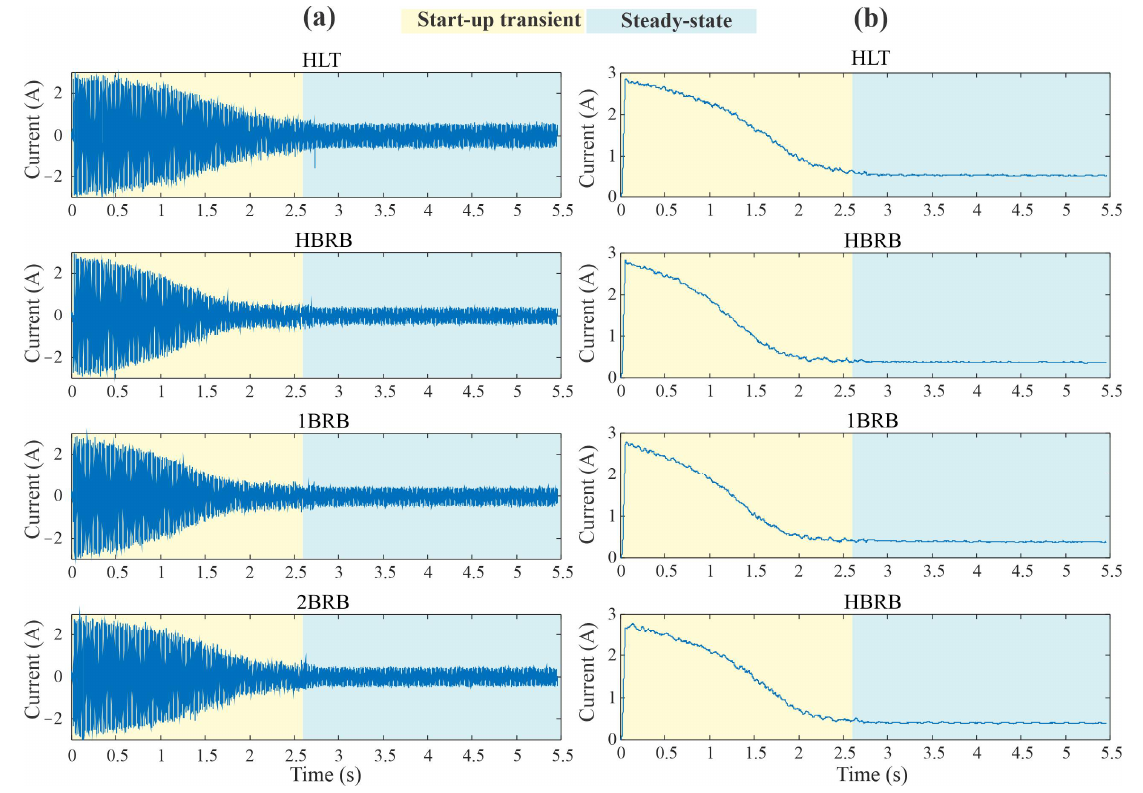
Figure 5. ( a ) Measured current signals for the analyzed IM conditions and ( b ) their estimated envelopes.